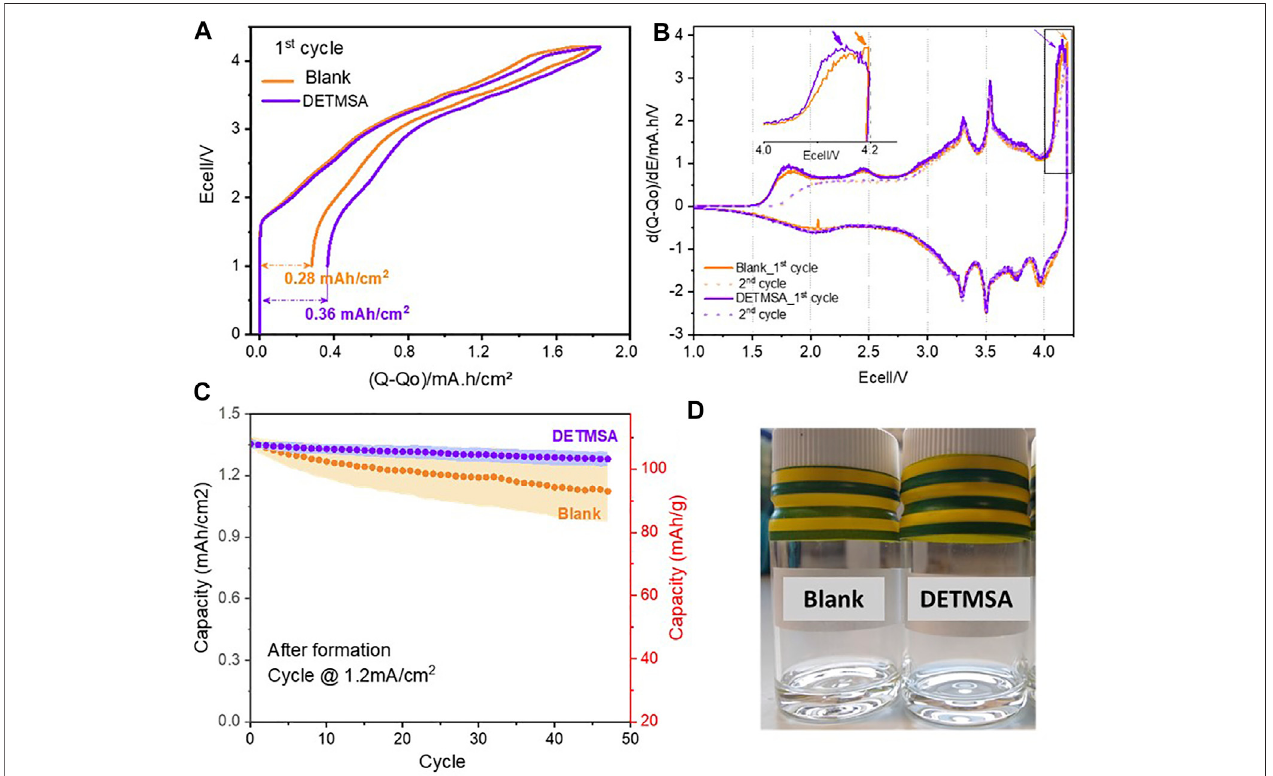
FIGURE2|(A) .Firstcharge/dischargepro fi le. (B) Differentialcapacity(dQ/dV)plotsand (C) cyclingperformancesofthefullcellwithblankelectrolyteandDETMSA electrolyte. (D) Images of freshly prepared electrolytes with and without